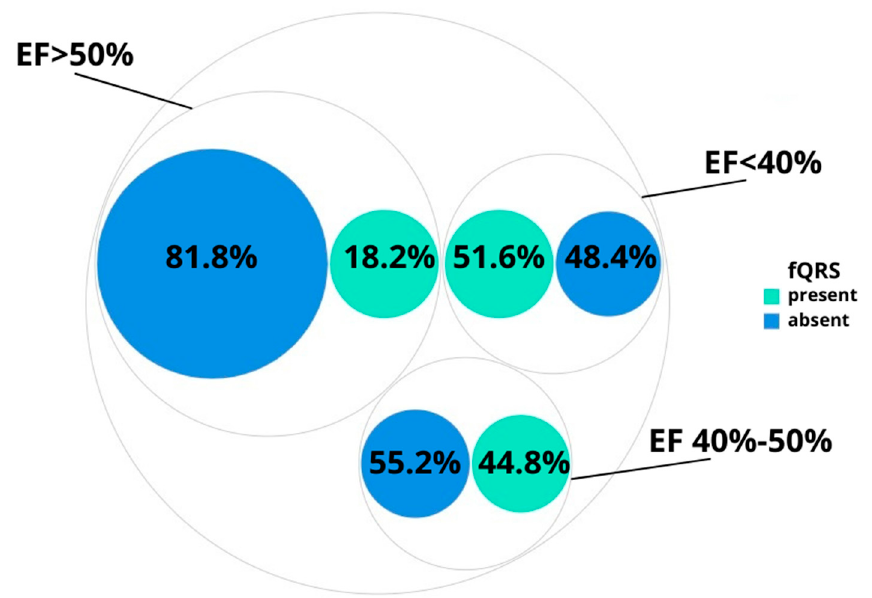
Figure 2. The occurrence of fQRS in the groups under study; EF—ejection fraction, fQRS—fragmented QRS complex.